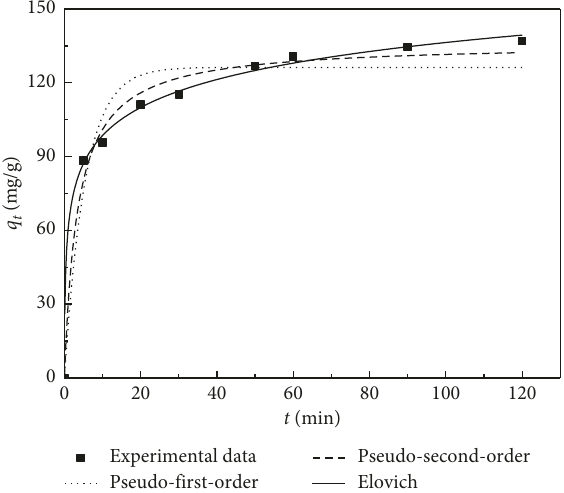
Figure 6: Adsorption kinetics of KRH